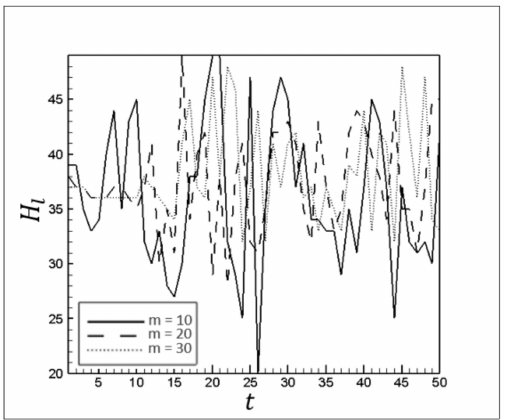
Figure 26. The attacking front height versus time for different